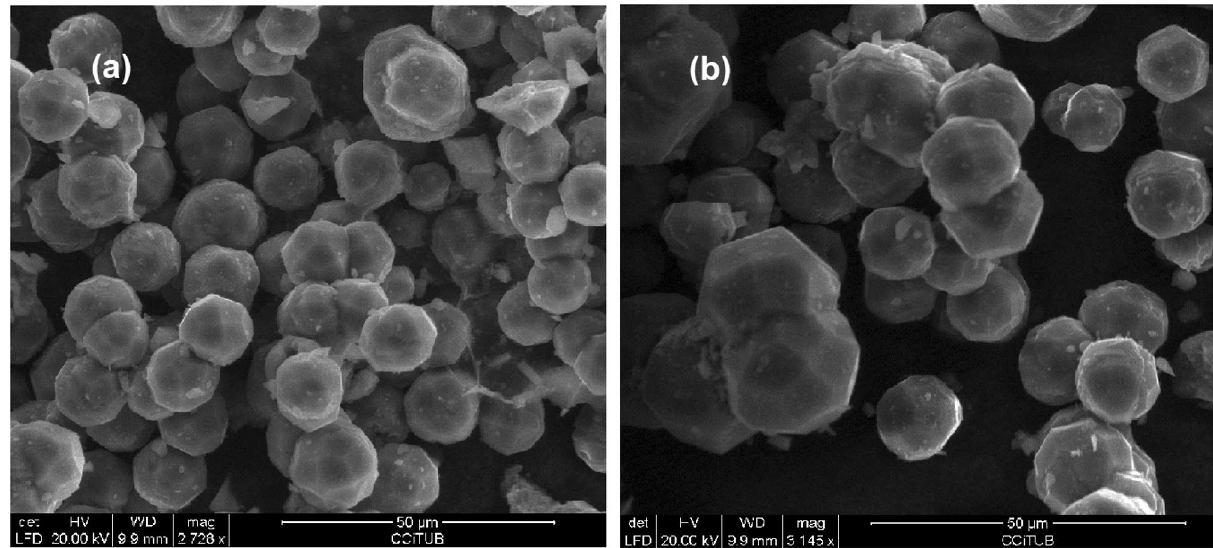
Figure 3. SEM images of analcime zeolite crystals obtained at 5 h ( a ) and at 10 h ( b ) of the synthesis